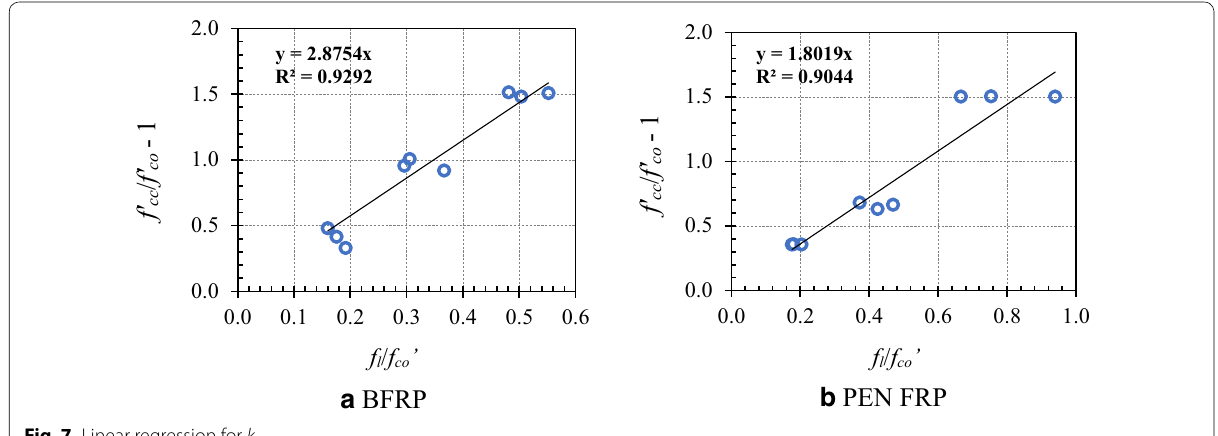
Fig. 7 Linear regression for k 1 .